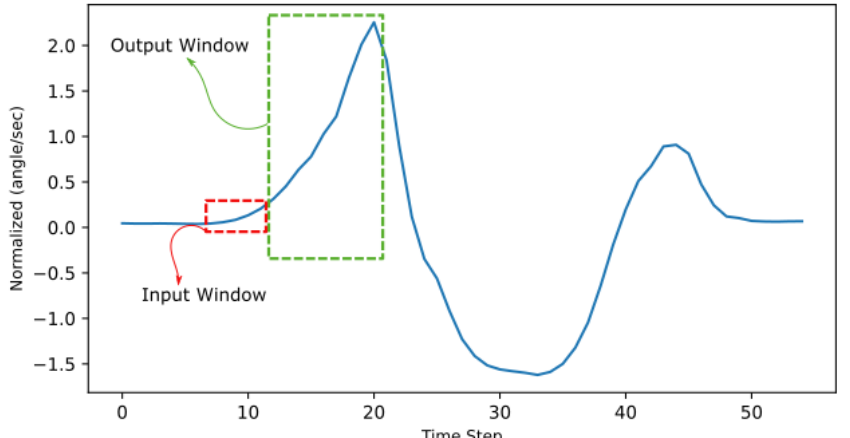
Figure 3. Sliding Window illustration on the ankle’s normalized angular velocity data (1 feature). The input Window of n samples and Output Windows of z samples, where n = 5 and z = 10.